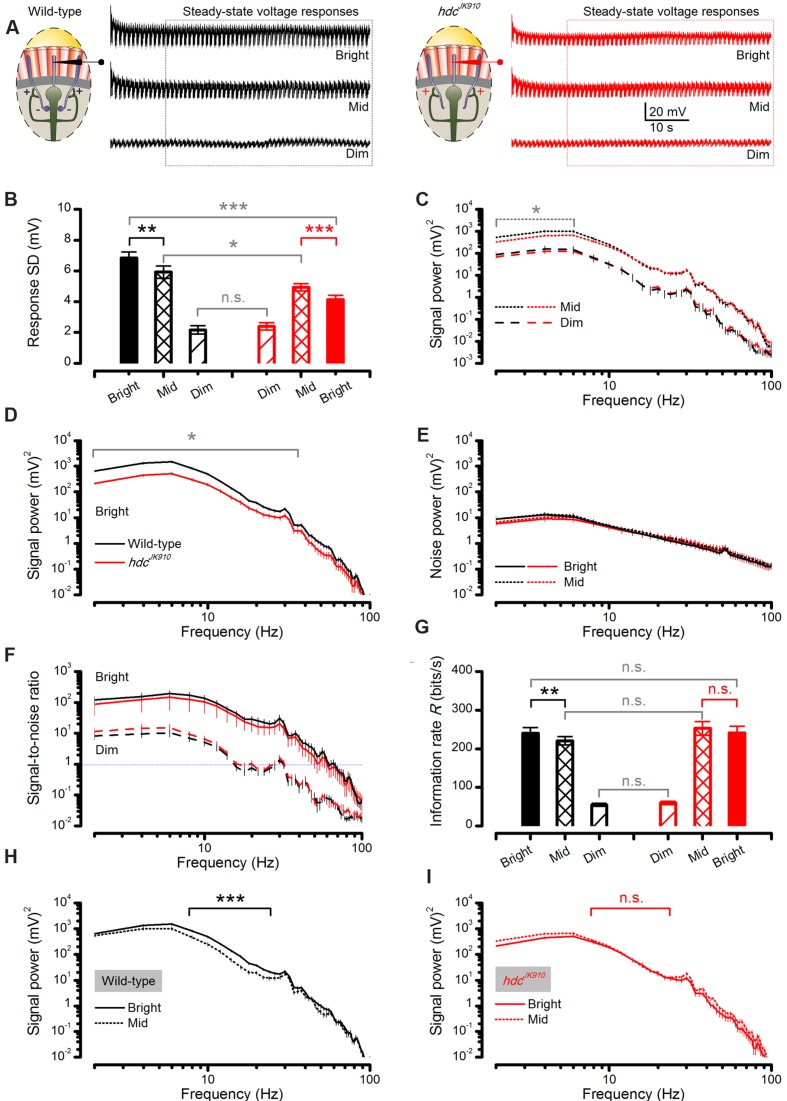
Steady-state-adapted hdcJK910 photoreceptor output to Mid and Bright naturalistic stimulation show less modulation but their information transfer is remarkably similar to the wild-type.
(A) Mean wild-type (black) and hdcJK910 (red) R1–R6 photoreceptors’ voltage response to a repeated 1 s long naturalistic light intensity time series pattern of different brightness. (B) In Bright and Mid, hdcJK910 R1–R6 output had significantly less modulation than the wild-type (Bright: SDwild-type = 6.85 ± 0.37 mV, SDhdc = 4.13 ± 0.27 mV, p = 4.427 × 10-5, one-tailed t-test; Mid: SDwild-type = 5.93 ± 0.40 mV, SDhdc = 4.92 ± 0.23 mV, p = 0.028, one-tailed t-test). In Bright, wild-type output modulation was the largest (p = 0.007, one-tailed paired t-test) while hdcJK910 modulation reduced in respect to Mid (p = 2.980 × 10-4, one-tailed paired t-test). In Dim, hdcJK910 and wild-type outputs showed similar modulation (Dim: SDwild-type = 2.16 ± 0.27 mV, SDhdc = 2.40 ± 0.23 mV, p = 0.520, two-tailed t-test). (C) In Mid, hdcJK910 signal had less power than the wild-type only in low frequencies (f < 6Hz, p < 0.029, one-tailed t-test). In Dim, hdcJK910 and wild-type signal power spectra were similar. (D) In Bright, hdcJK910 R1–R6 output had less signal power than the wild-type over a broad frequency range (f < 34Hz, p < 0.023, one-tailed t-test). (E) Noise power spectra of wild-type and hdcJK910 photoreceptor outputs were similar to all three tested brightness levels. Data in Dim condition is not shown for clarity. (F) Signal-to-noise ratios of wild-type and hdcJK910 photoreceptor outputs were remarkably similar over the three tested brightness levels. Data for Mid stimulation are not shown for clarity. (G) Information transfer rate estimates of wild-type and mutant photoreceptor outputs were remarkably similar (Dim: Rwild-type = 54.73 ± 3.67, Rhdc = 59.53 ± 4.23; Mid: Rwild-type = 220.44 ± 10.75, Rhdc = 252.92 ± 17.86; Bright: Rwild-type = 240.40 ± 14.62, Rhdc = 240.64 ± 17.41, all in bits/second, p > 0.05, two-tailed t-test). Wild-type photoreceptors showed higher information transfer rates in Bright stimulation than in Mid (p = 0.004, one-tailed paired t-test) while hdcJK910 photoreceptors encoded similar information rates in Mid and Bright (p = 0.138, two-tailed paired t-test). (H) For 8–24 Hz frequency range, wild-type photoreceptor outputs to Bright naturalistic stimulation carried significantly more power than to Mid intensities (p < 0.001, paired one-tailed t-test). (I)
hdcJK910 photoreceptor outputs to Bright and Mid naturalistic stimulations had similar power spectra (p > 0.05, paired two-tailed t-test). (A–I): Mean ± SEM, nwild-type = 7, nhdc = 8. All recordings performed at t = 19°C.